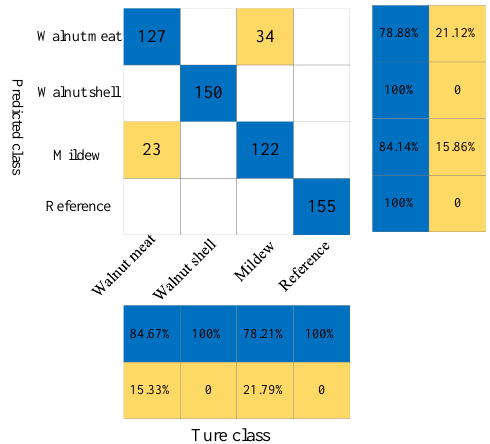
Figure 5. The confusion matrix of prediction results of walnut shell, walnut kernel, mildew sample and reference signal under SVM model.